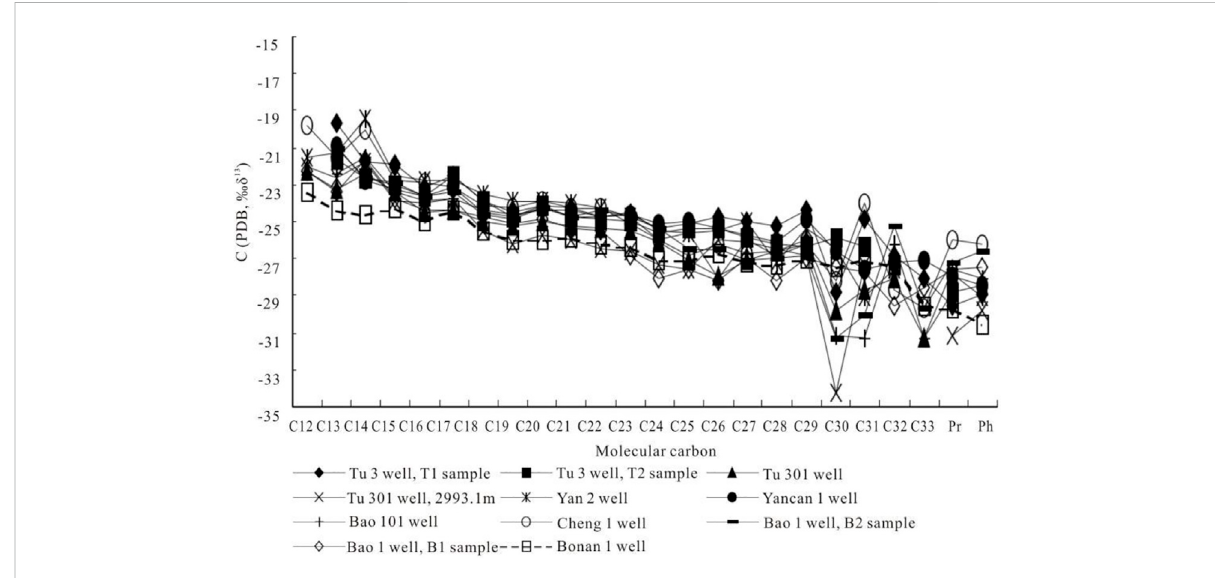
FIGURE 5 Distribution characteristics of carbon isotopes in the Lower Jurassic crude oil molecules in the study area.